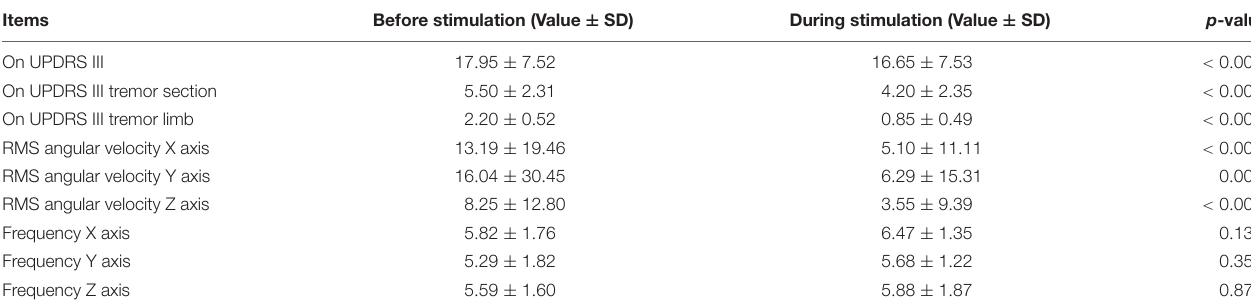
TABLE 4 | Comparison of tremor parameters between the before-stimulation and during-stimulation